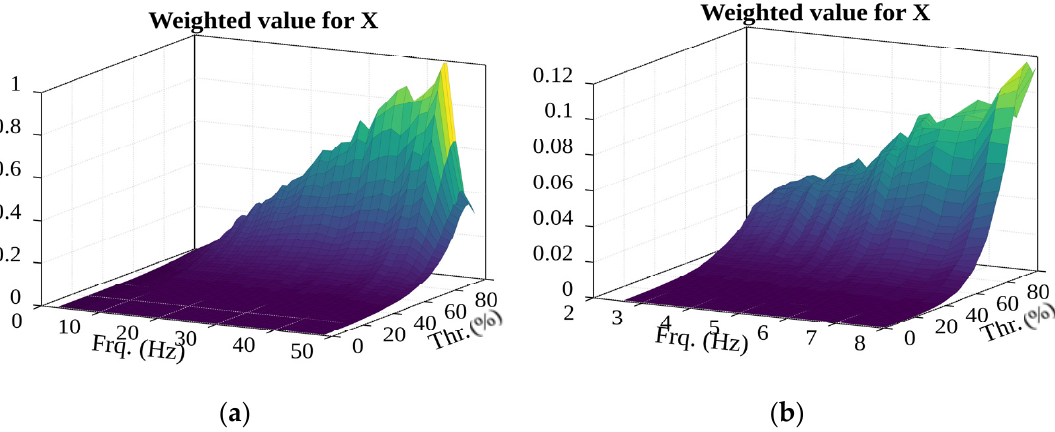
Figure 26. The surface of weighted value of potential events (in the ( a )—2.6–49 Hz; ( b )—2.6–8 Hz frequency range).